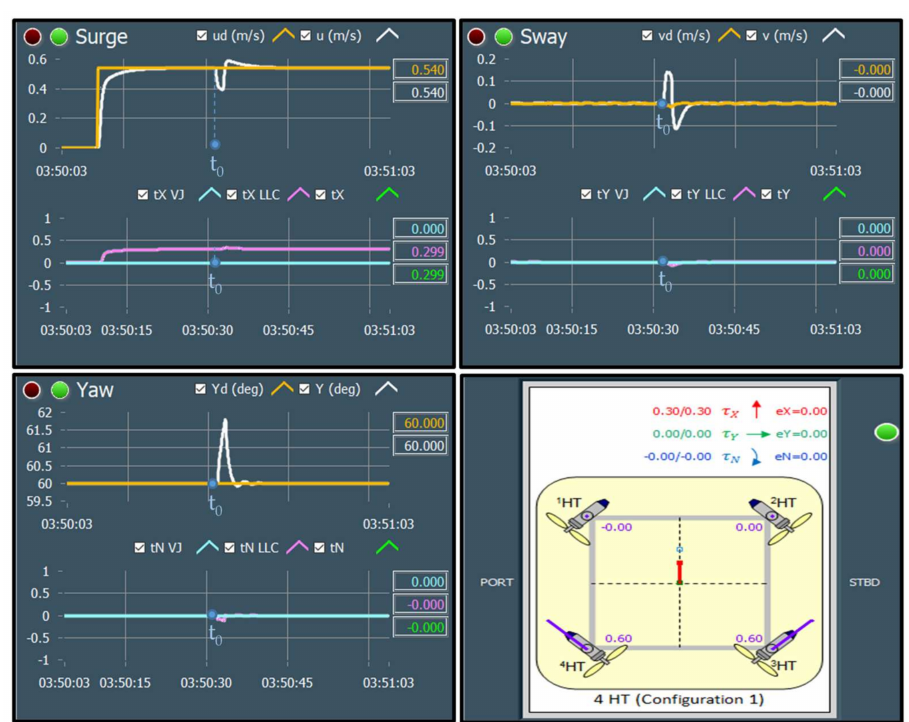
Figure 27. Test 3 (Closed-Loop): Total fault in HT2 (“Broken Propeller”) occurred at t 0 ; excellent control performance is achieved due to fault accommodation and robustness of closed-loop